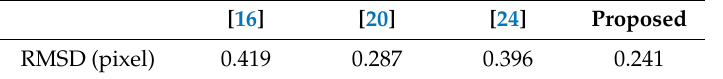
Table 3. Overall evaluation result for four different approaches.